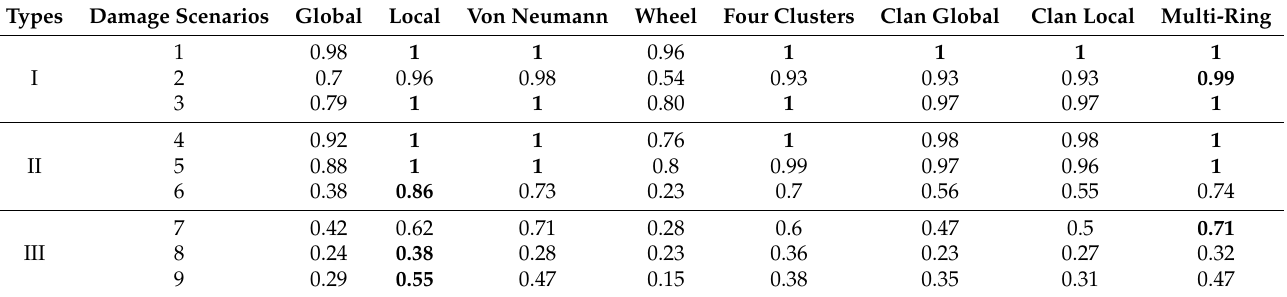
Table 3. The comparison results of success rate and for each damage scenario among PSO topologies.